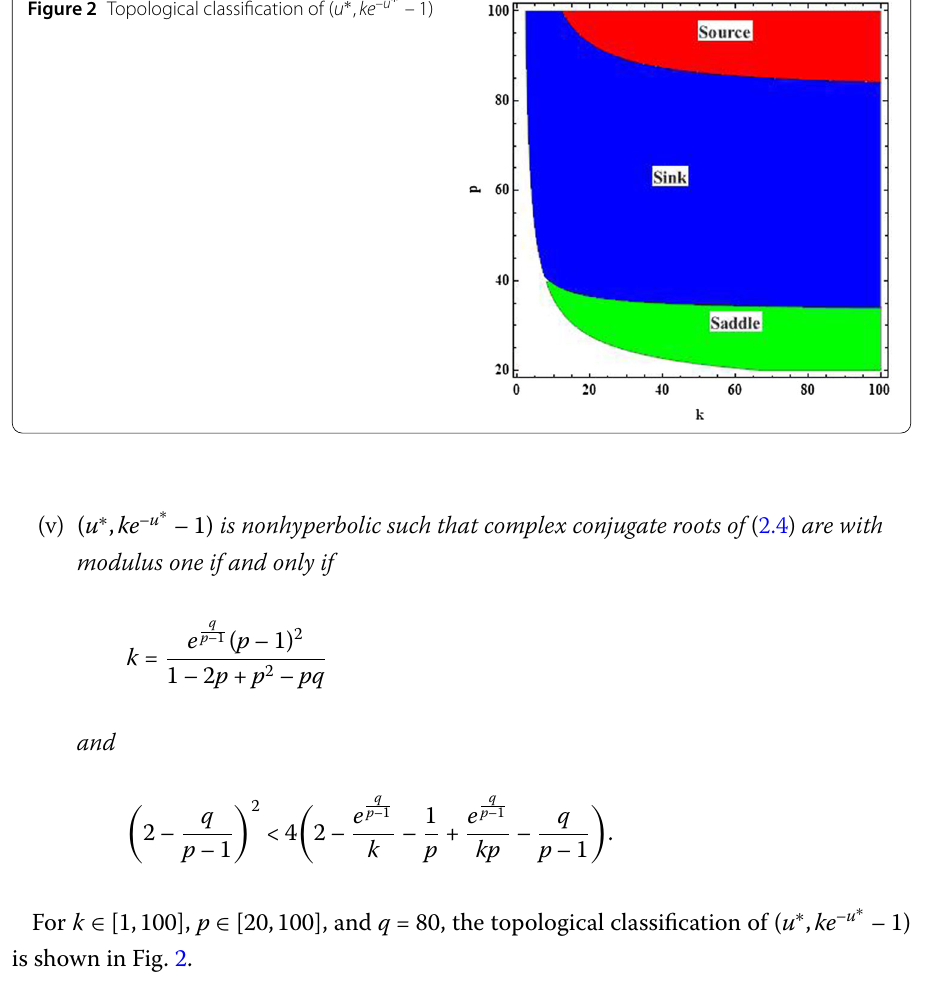
Figure 2 Topological classification of ( u ∗ , ke – u